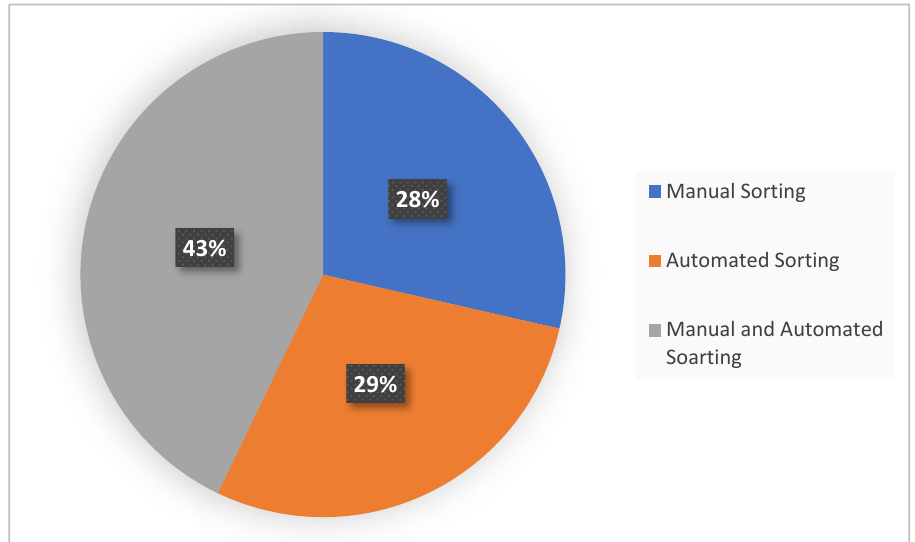
Figure 2. Breakdown of sorting methodologies currently used at MRFs in the U.S.